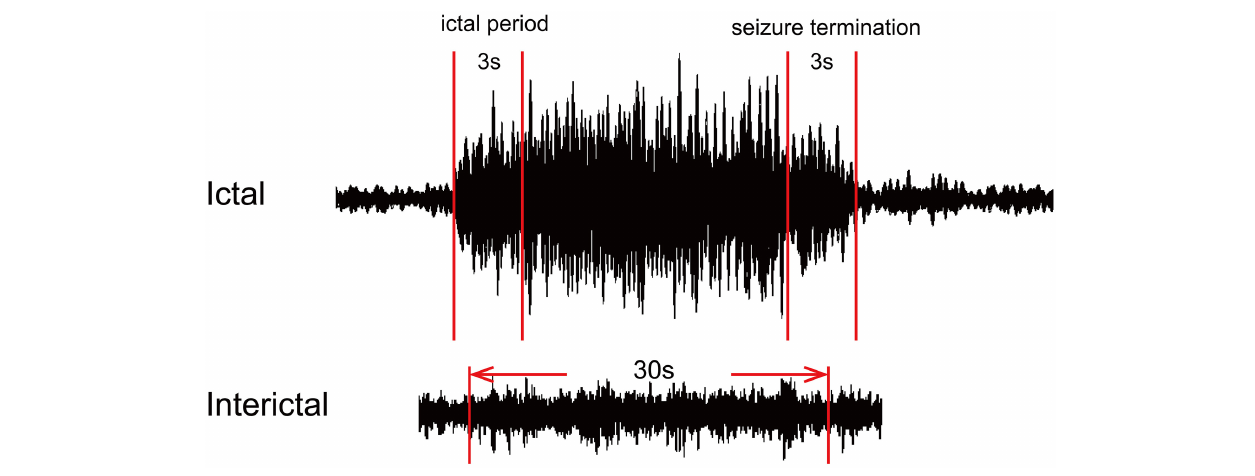
FIGURE 1 | Schematic diagram of magnetoencephalography (MEG) waveform data. For each MEG recording, two segments with a duration of 3s represented the ictal period and termination period, and one 30-s segment was selected as the interictal